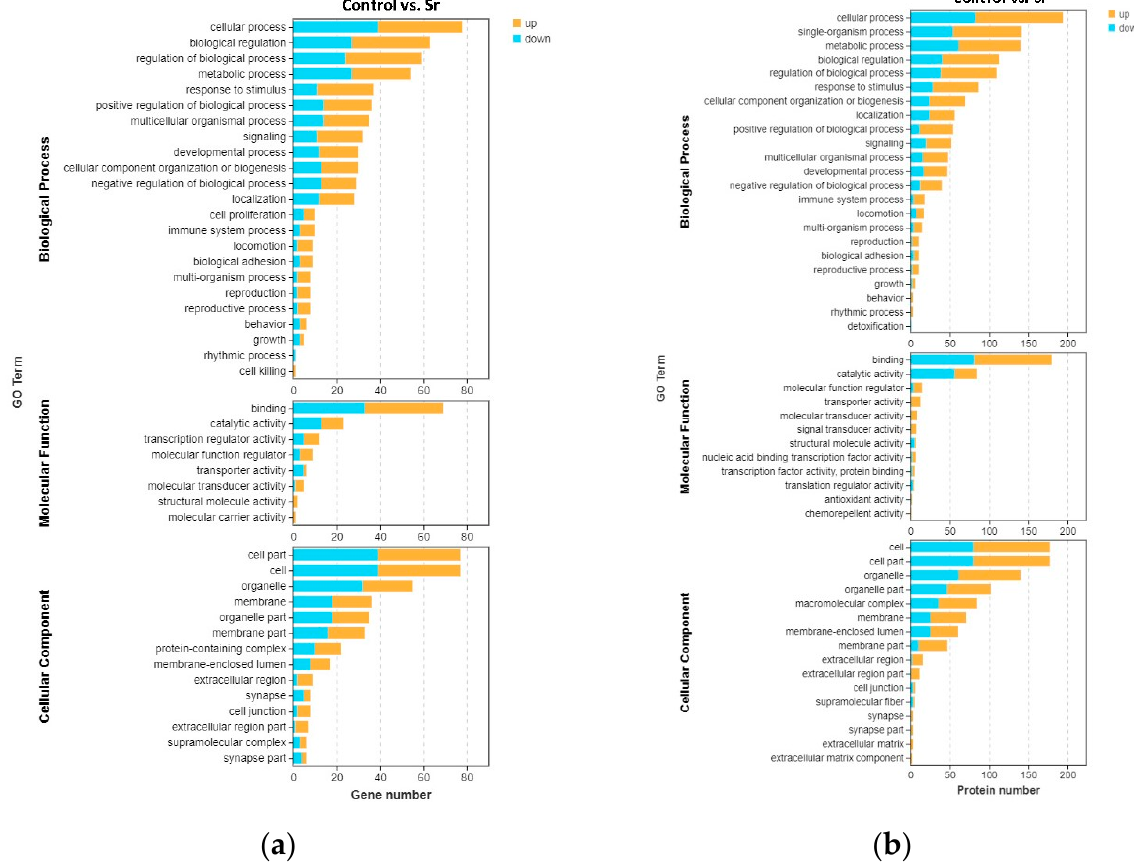
Figure 1. GO categories of the differentially regulated transcripts ( a ) and proteins ( b ) in bovine chondrocytes between the control and Sr-treated groups. The ordinate is the GO terms, and the abscissa indicates the number of the differentially expressed genes annotated to GO terms. The blue bars represent down-regulated molecules, whereas the yellow bars represent up-regulated mole- cules.